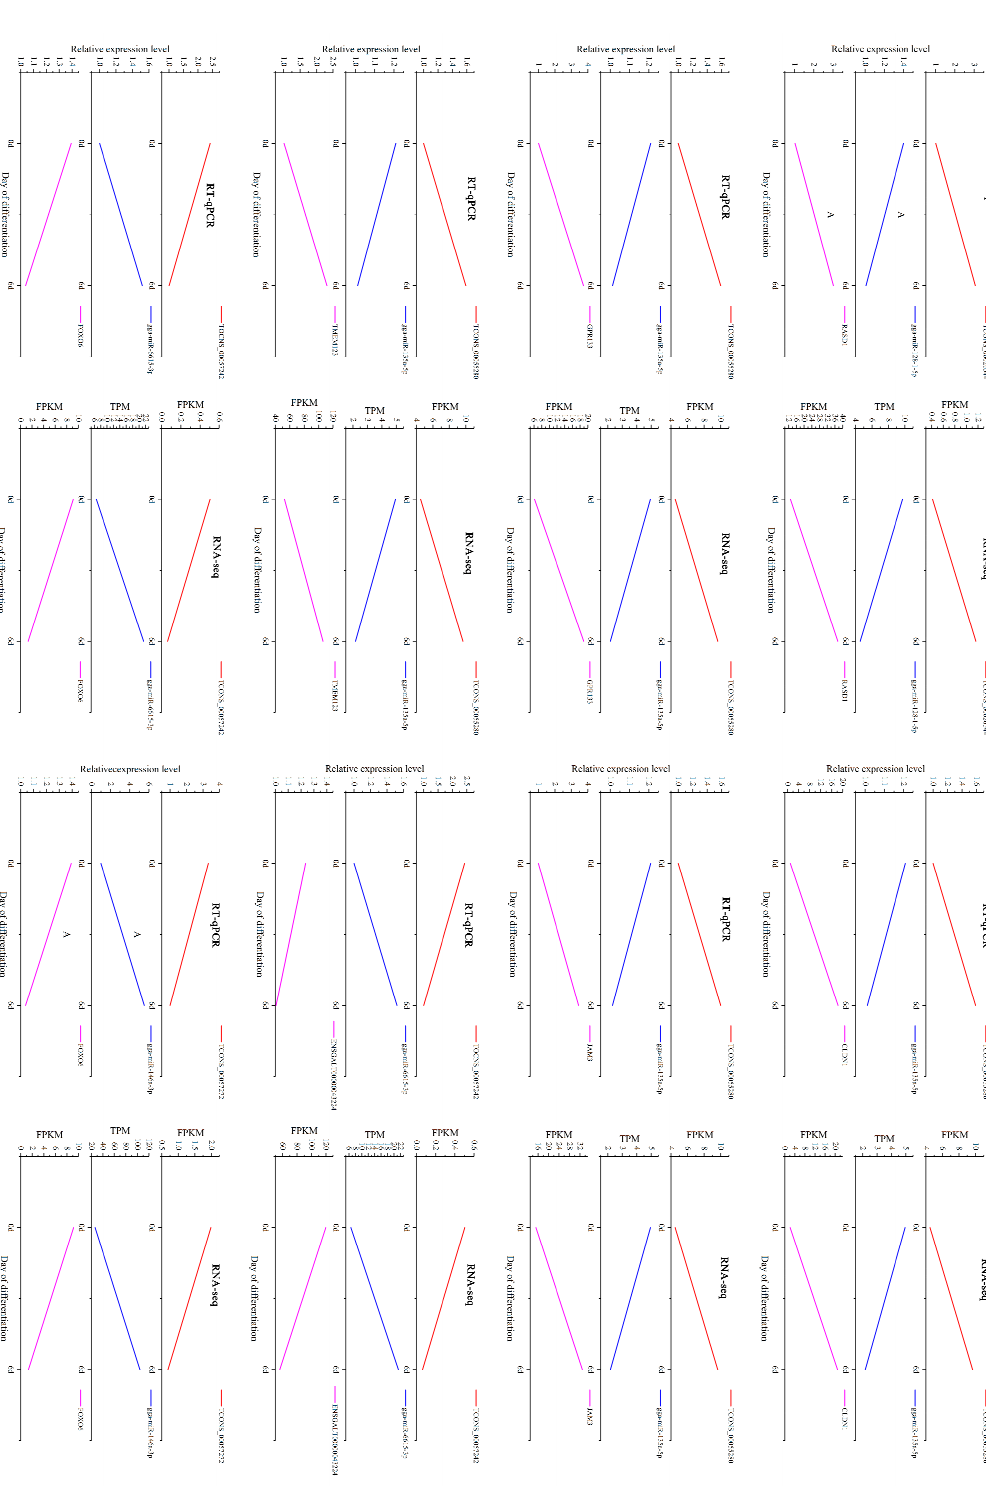
Figure 7. Validation of crucial ceRNA interactions using quantitative reverse transcription polymerase chain reaction (RT-qPCR). Red, blue, and pink lines indicate lncRNA, miRNA, and mRNA, respectively. Eight out of twelve ceRNA interactions were validated using RT-qPCR, including TCONS_00026544-gga-miR-128-1-5p-RASD1, TCONS_00057272-gga-miR-146a-3p-FOXO6, TCONS_00057242-gga-miR-6615-3p-FOXO6, TCONS_00057242-gga-miR-6615-3p-ENSGALT000000 43224, TCONS_00055280-gga-miR-135a-5p-JAM3, TCONS_00055280-gga-miR-135a-5p-GPR133, TCONS_00055280-gga-miR-135a-5p-CLDN1,